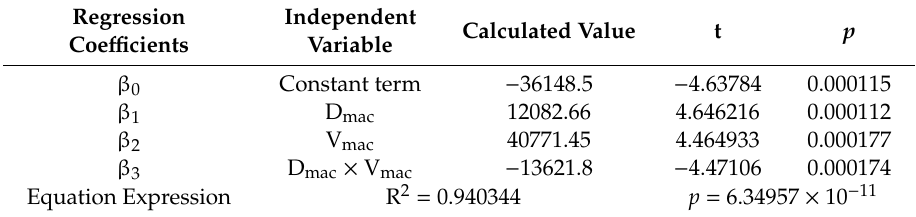
Table 10. Calculation results of multiple linear regression of independent variables.